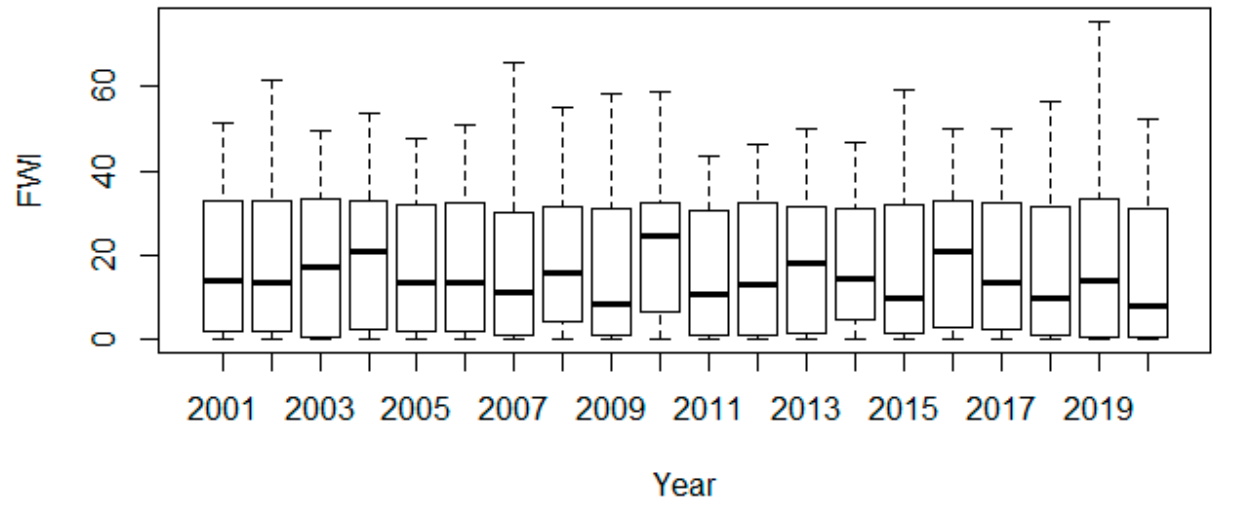
Figure 10. Median, standard deviation, 95% confidence interval, and outliers of yearly values of FWI in Lebanon for the period 2001–2020.